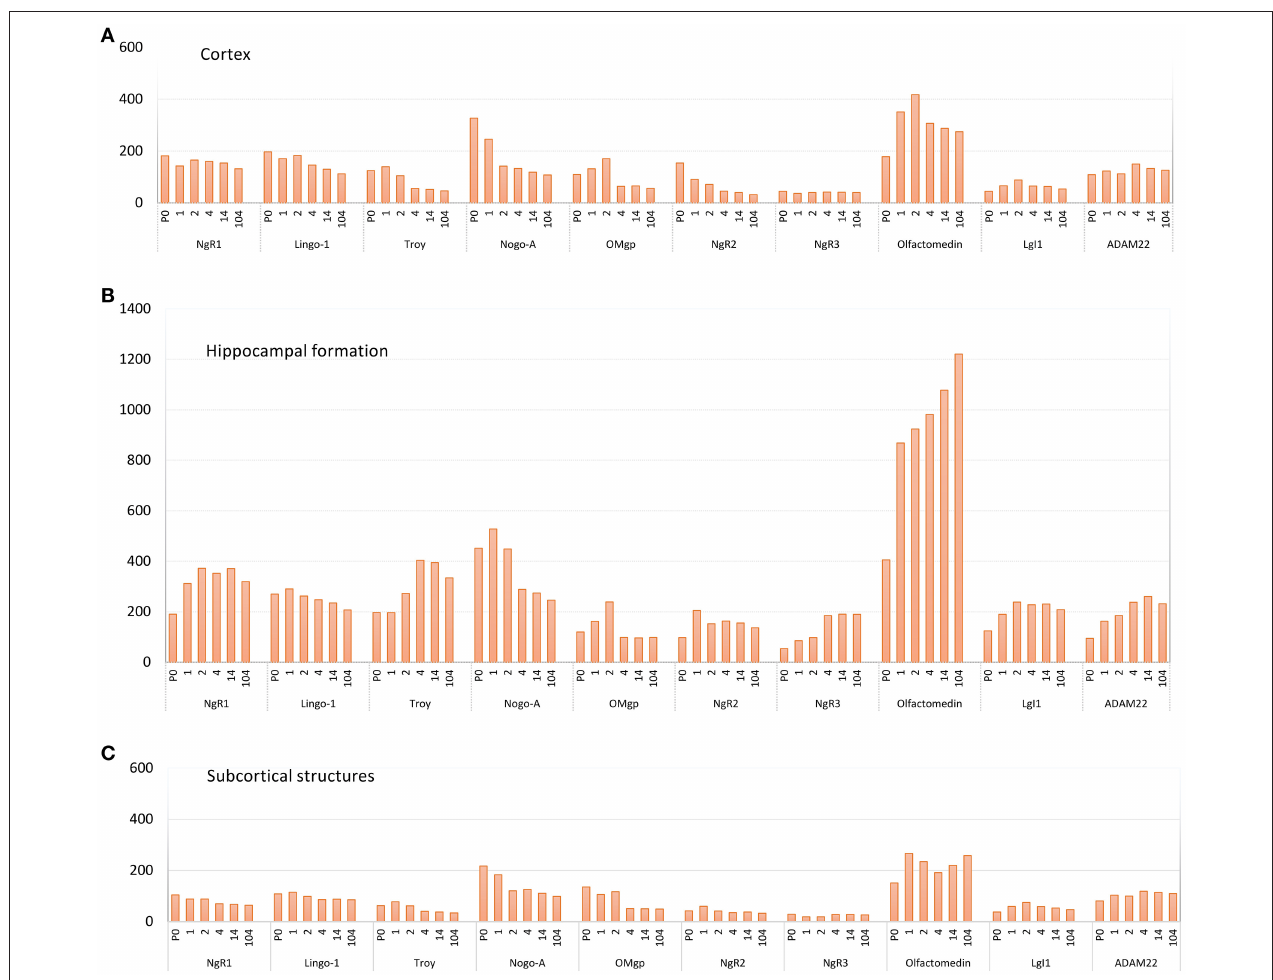
FIGURE 5 | Pooled average expression of all subregions in the three main regions over time for each gene; (A) cortex, (B) hippocampal formation and (C) subcortical structures. Subregions are found in Figure 3 . Y-axis: expression in nCi/g.